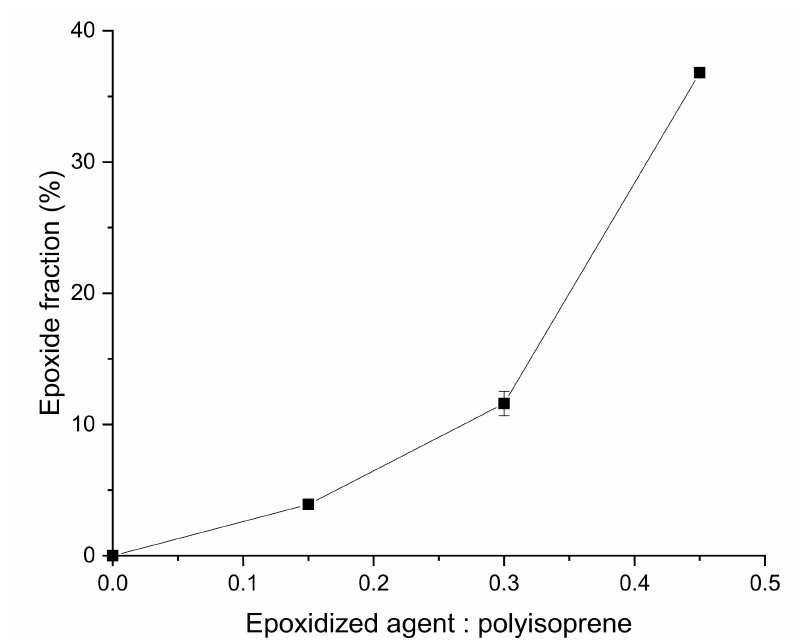
Figure 2. Epoxide fraction of epoxidized guayule natural rubber.